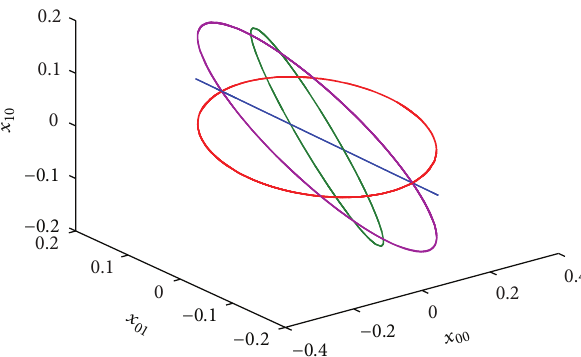
Figure 3: System (42) has multiple periodic solutions when 𝜏 = 3